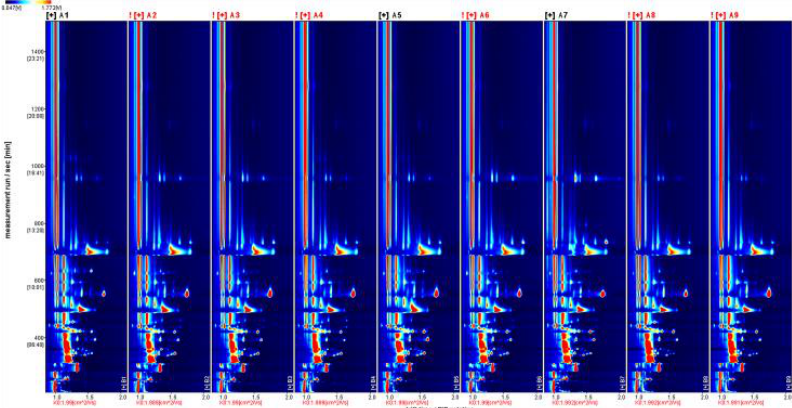
Figure 5. HS-GC-IMS 2D spectrum (top view). Note: From A1 to A9 are ‘Hassan’, ‘Zuoshaner’, ‘Beibinghong’, ‘Zuoyouhong’, ‘Beta’, ‘Shuanghong’, ‘Zijingganlu’, ‘Cabernet Sauvignon’, and ‘Syrah’. The entire graph has a blue background, and the red vertical line at the horizontal coordinate 1.0 is the RIP peak (reactive ion peak, normalized). Each point on either side of the RIP peak represents a volatile organic compound.